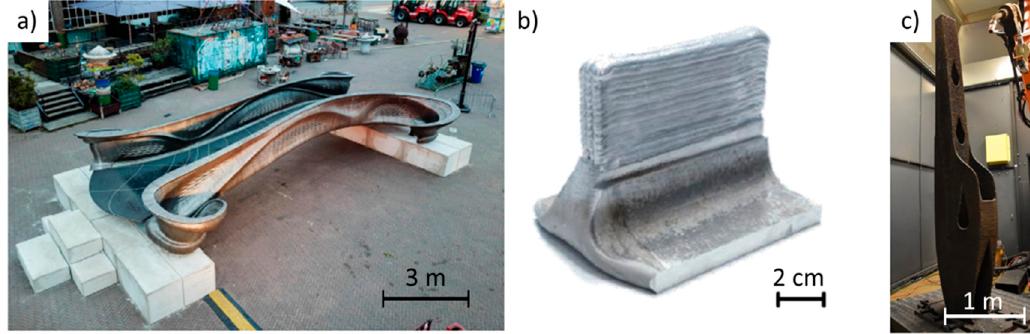
Figure 33. Various components made with WAAM: ( a ) MX3D bridge [168], ( b ) rib [166], and ( c ) excavator arm [169].